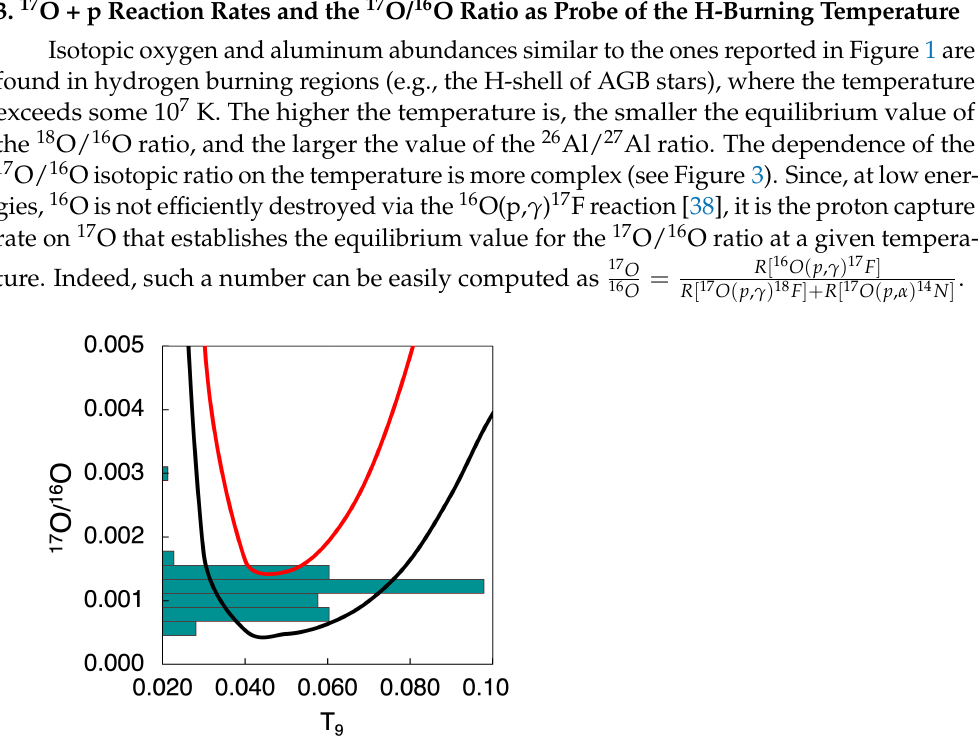
Figure 3. The 17 O/ 16 O equilibrium values as a function of temperature (in units of 10 9 K) computed using the reaction rates of set A (red curve) and set B (black curve). We report the calculation results only for the rate recommended values, being these former the inputs employed for nucleosynthesis calculation. The cyan histogram marks the 17 O/ 16 O distribution in group 2 oxide